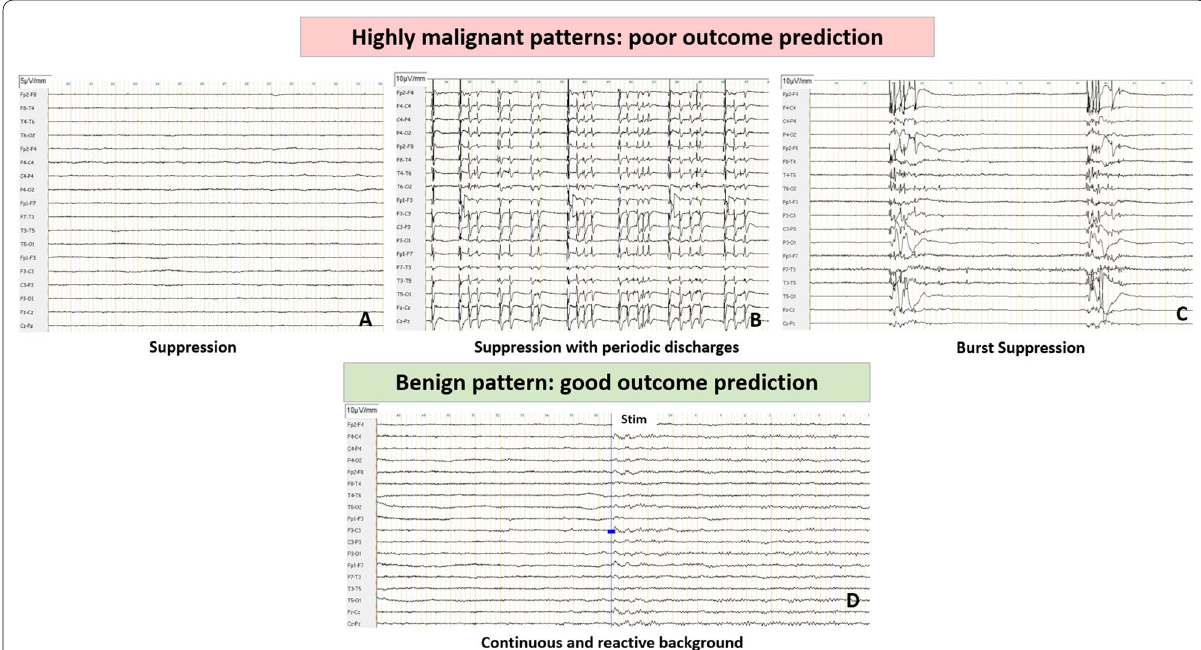
Fig. 1 Highly malignant and benign EEG patterns (adapted from Westhall et al. [58] and ACNS terminology [32]). A , B , C Figures represented EEG longitudinal montage showing highly malignant patterns. A Suppression, defined as suppressed EEG background (amplitude < 10 µV all the time of the recording) without discharges. B Suppression with periodic discharges, defined as a suppressed EEG background with continuous periodic discharges (spikes, poly‑spikes, sharp or waves). C Burst suppression, defined as suppression periods (< 10 µv) constituting > 50% of the recording with “burst”. D EEG longitudinal montage showing benign EEG, defined as the absence of a malignant or highly malignant features namely continuous or nearly continuous and reactive EEG background. Blue line indicated the nociceptive stimulus (nail pressure), inducing amplitude and frequency modifications and defining reactivity when